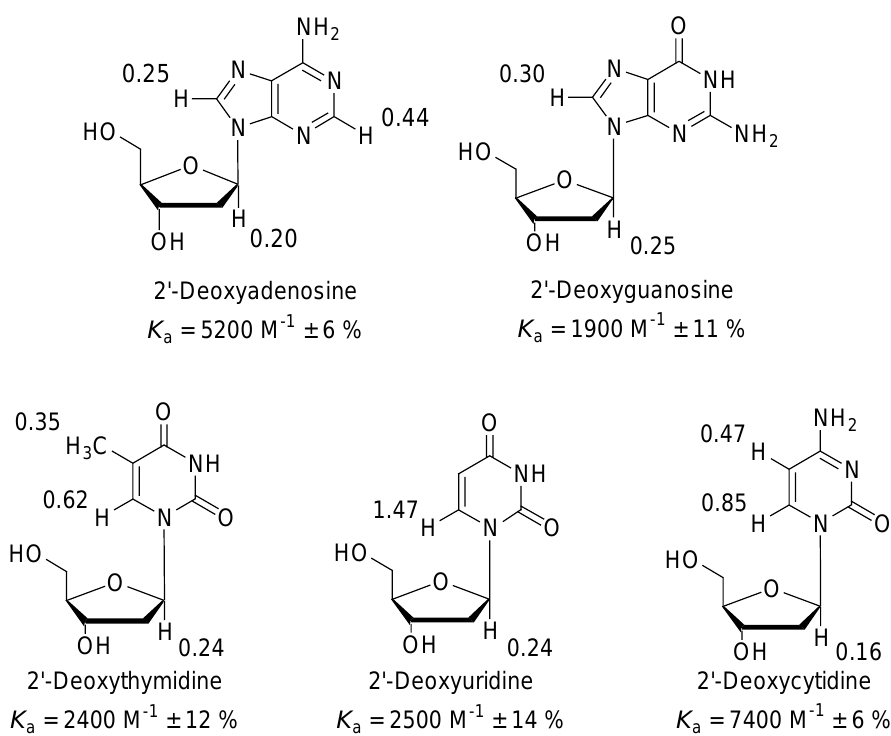
Figure 2. Nucleosides bound by clip 1 , with corresponding binding constants [M -1 ] and maximum chemical shift changes ∆δ max